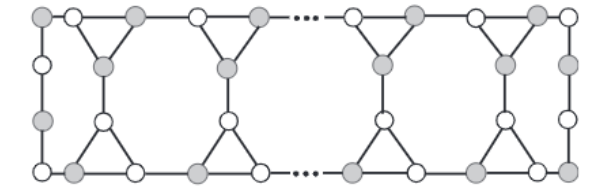
Figure 3: Line graph of ladder